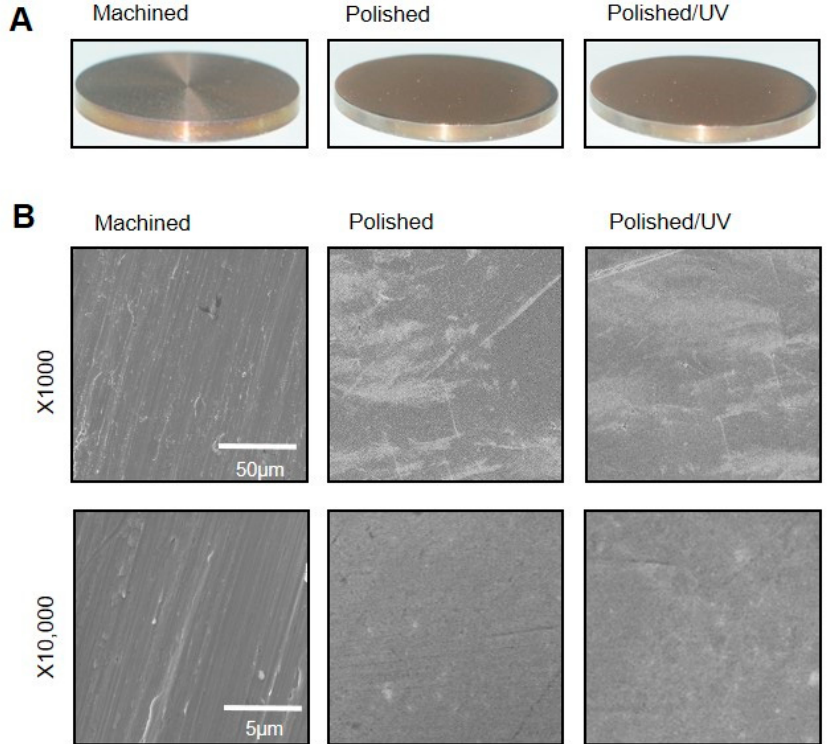
Figure 1. Surface morphology of the titanium disks used in this study. ( A ) Samples of the titanium disks. ( B ) Scanning electron microscopy (SEM) images of the machined surface, polished surface and polished/UV surface. Scale bar = 50 μ m (1000 × magnification) and 5 μ m (10,000 × magnification).